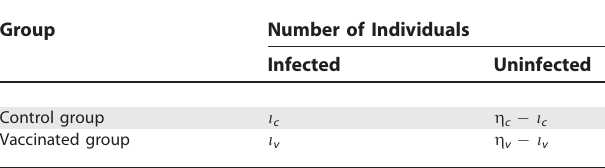
Table 2. Contingency Table of a Repeated Low-Dose Challenge Experiment Group Number of